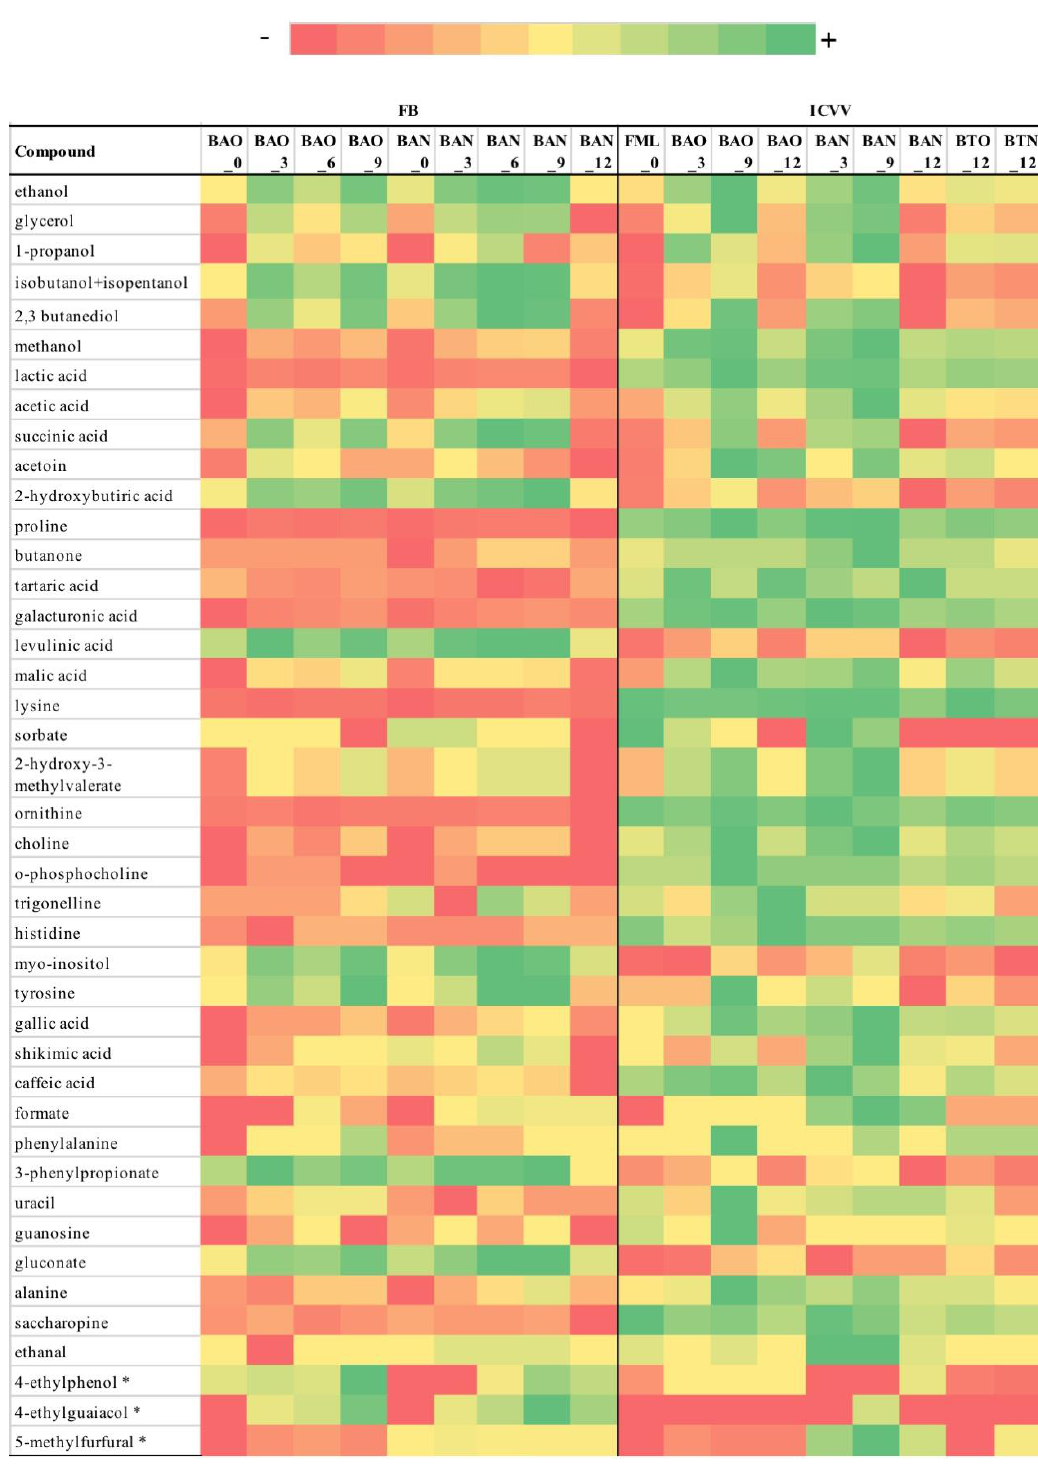
Figure 3. Color coded visualization of Table S2 included in the Supplementary Materials showing the metabolites detected by NMR and targeted GC-MS for cellars FB ( left ) and ICVV ( right ). The color gradient was individualized for the range of detection of each metabolite. Numbers at the end of the sample acronyms represent the sampling month. Targeted GC-MS metabolites are indicated with an asterisk.